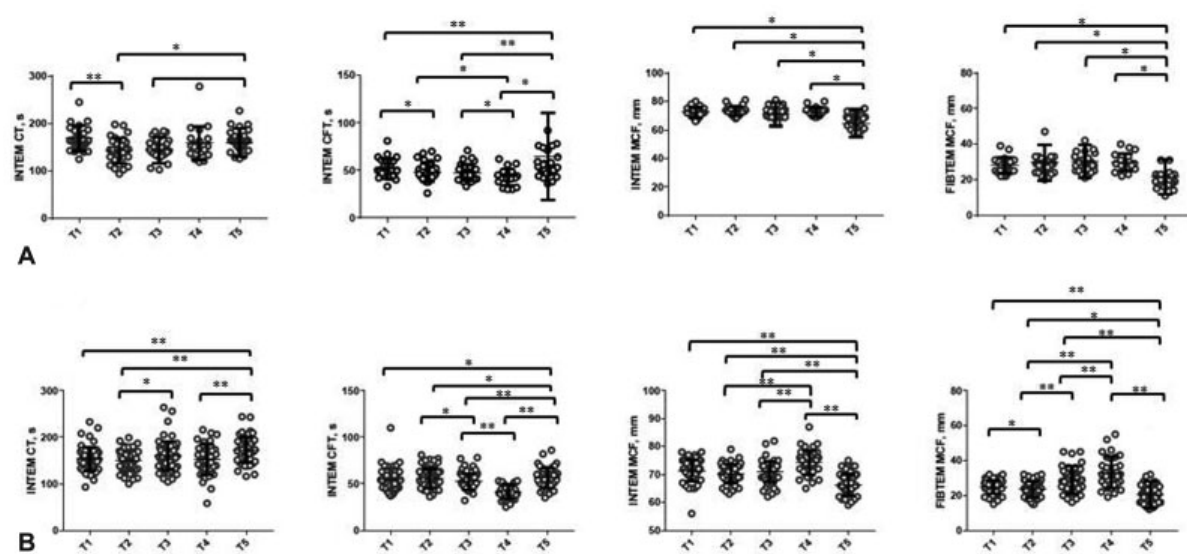
Fig. 2 INTEM and FIBTEM parameters in women before (T1) and after vaginal delivery ( A ) or caesarean section ( B ) (T2), following enoxaparin (T3), at 1 week postpartum (T4) and 6 weekspostpartum (T5). (cid:6) p < 0.001, (cid:6)(cid:6) p > 0.001 and < 0.05. Followinga Bonferroni correction, signi fi cance was assumed at α <